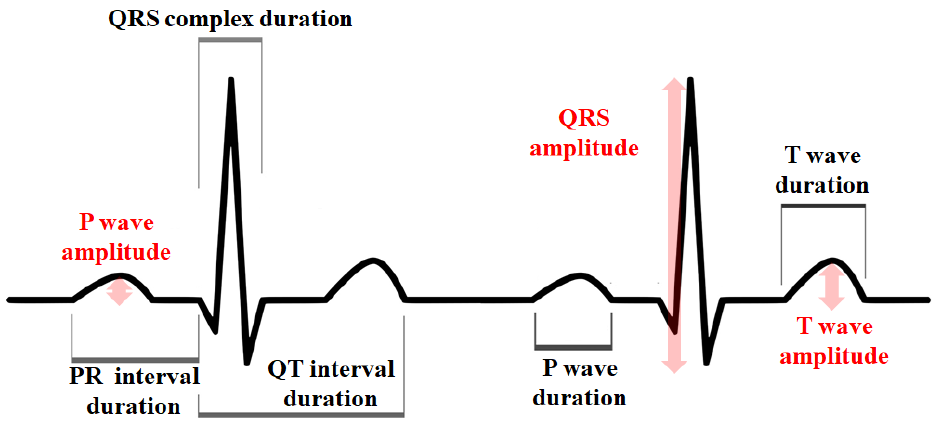
Figure 2. Electrocardiogram characteristics used for the assessment.